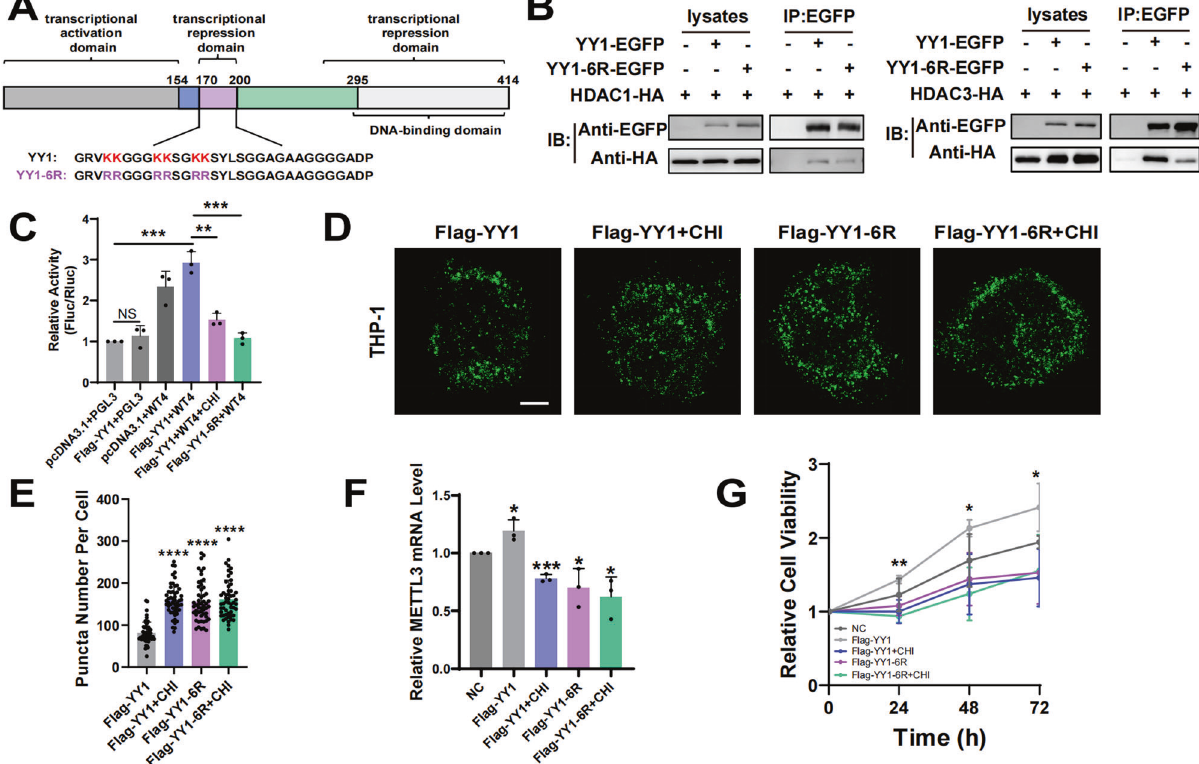
Fig. 6 YY1 HDAC1/3 binding sites mutations affects its regulation of METTL3 and AML cell proliferation. A Domain structure of the YY1 protein. YY1-6R represent YY1 arginine mutant. B Coimmunoprecipitation (Co-IP) assays for association of HDAC1/3-HA with YY1-6R-EGFP. Co- transfected YY1-EGFP or YY1-6R-EGFP with HDAC1/3-HA, the cell extracts were prepared and precipitated with anti-EGFP beads, and detected by using immunoblotting with anti-EGFP and anti-HA antibodies ( n = 3). C Luciferase activity in 293T cells co-transfected with the wide type YY1 or Flag-YY1-6R and the luciferase reporter vectors, with or without CHI treatment for 24 h, assessed by luciferase reporter assay. ** P < 0.01; *** P < 0.001; NS = nonsigni fi cant, t -test. D THP-1 cells were transfected with Flag-YY1 or Flag-YY1-6R mutant plasmids, with or without 4 μ M CHI treatment for 1 h, and performed immuno fl uorescence analysis with anti-Flag antibody. E The number of fl uorescent particles of fi gure ( D ). **** P < 0.0001, t -test. Scale bar, 5 μ m. F THP-1 cells were transfected with Flag-YY1 or Flag-YY1-6R mutant plasmids, with or without 4 μ M CHI treatment for 24 h, and detected the expression of METTL3 by qPCR. * P < 0.05; *** P < 0.001, t -test. G The proliferation ability of THP-1 cells transfected with Flag-YY1 or Flag-YY1-6R mutant plasmids, with or without 4 μ M CHI treatment, and detected by CCK-8 assay. * P < 0.05; ** P < 0.01, one-way